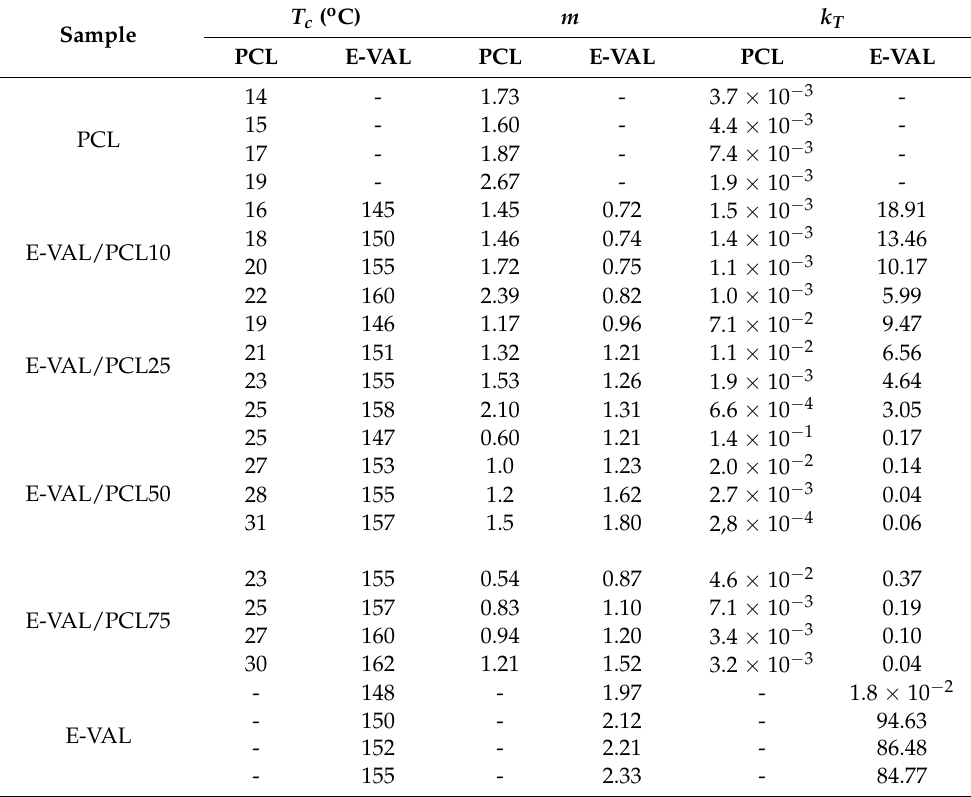
Table 9. Ozawa parameters representing the non-isothermal crystallization kinetics of pure